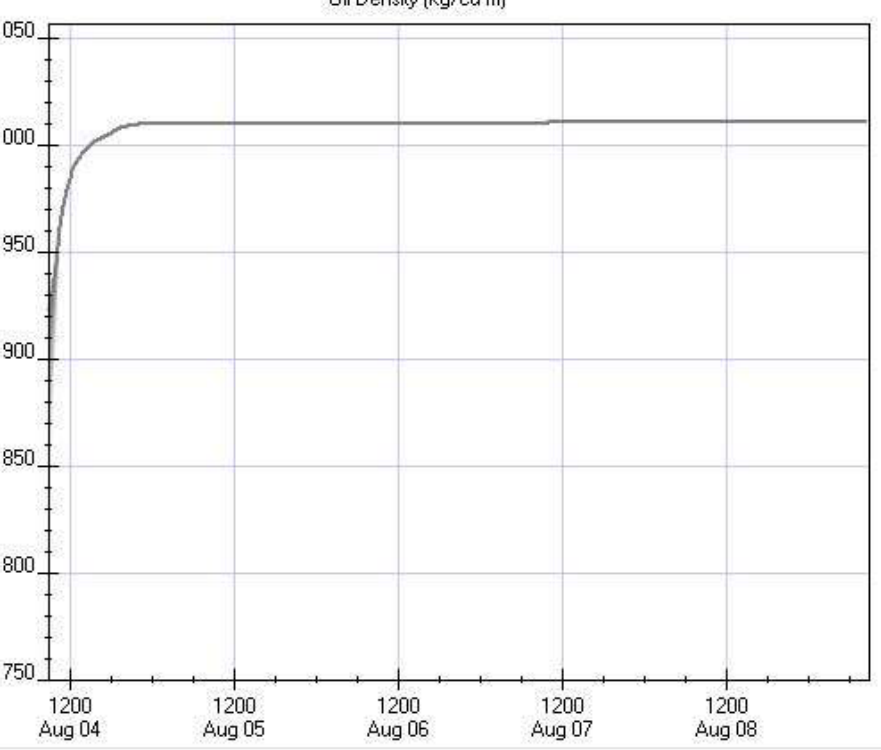
Figure 2. Changes in oil (Arabian extra light (Aramco)) density over time on the surface of water (from the ADIOS program).